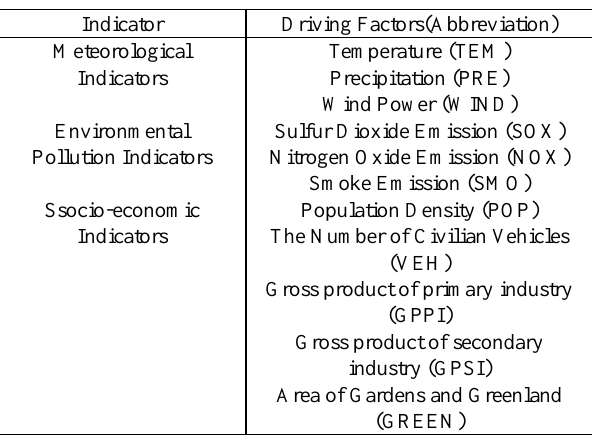
Table 1. Indicators System of AOD Driving